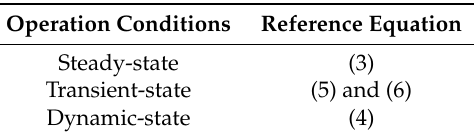
Table 2. Operation conditions